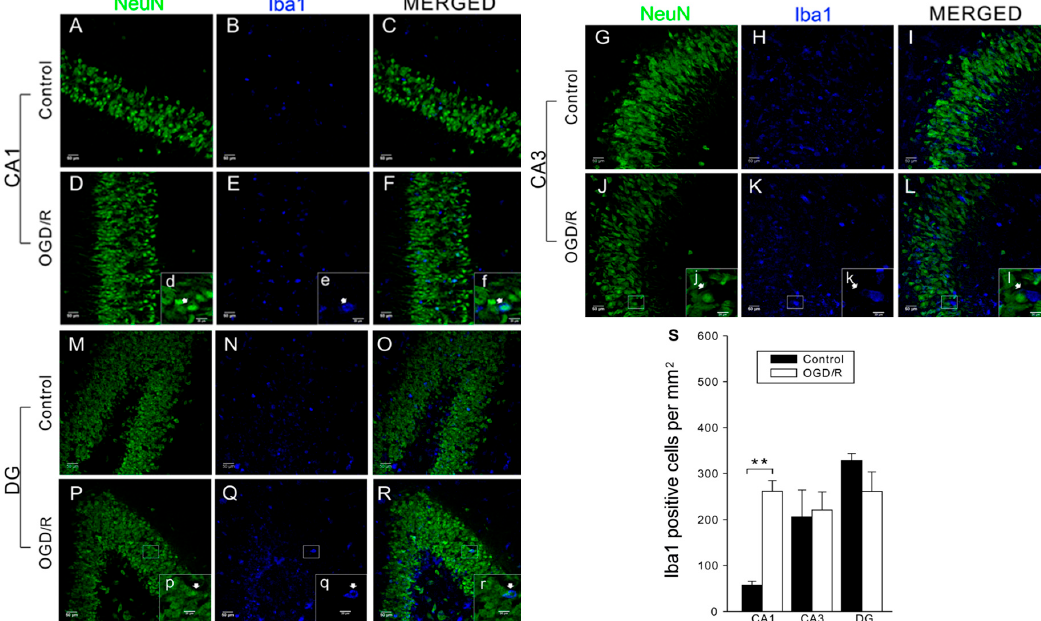
Figure 4. Oxygen–glucose deprivation/reperfusion (OGD/R) promoted microglia activation in hippocampal slices. In each picture, the large area with lowercase letter is enlarged from the small area in white box; the white arrows point at labeled cells and the corresponding area. ( A – R ) Examples of neuron-specific nuclear protein (NeuN)-labeled neurons ( green ) and ionized calcium binding adapter molecule 1 (Iba1)-labeled microglia ( blue ). Scale bar: 50 μ m; ( D – R ) scale bar: 20 μ m; ( S ) the density of Iba1-positive cells (cells/mm 2 ) in CA1, CA3, and dentate gyrus (DG) before and after OGD/R. The data are expressed as the mean ± standard error of the mean (SEM) ( n = 5–8). * p < 0.05, ** p < 0.01.